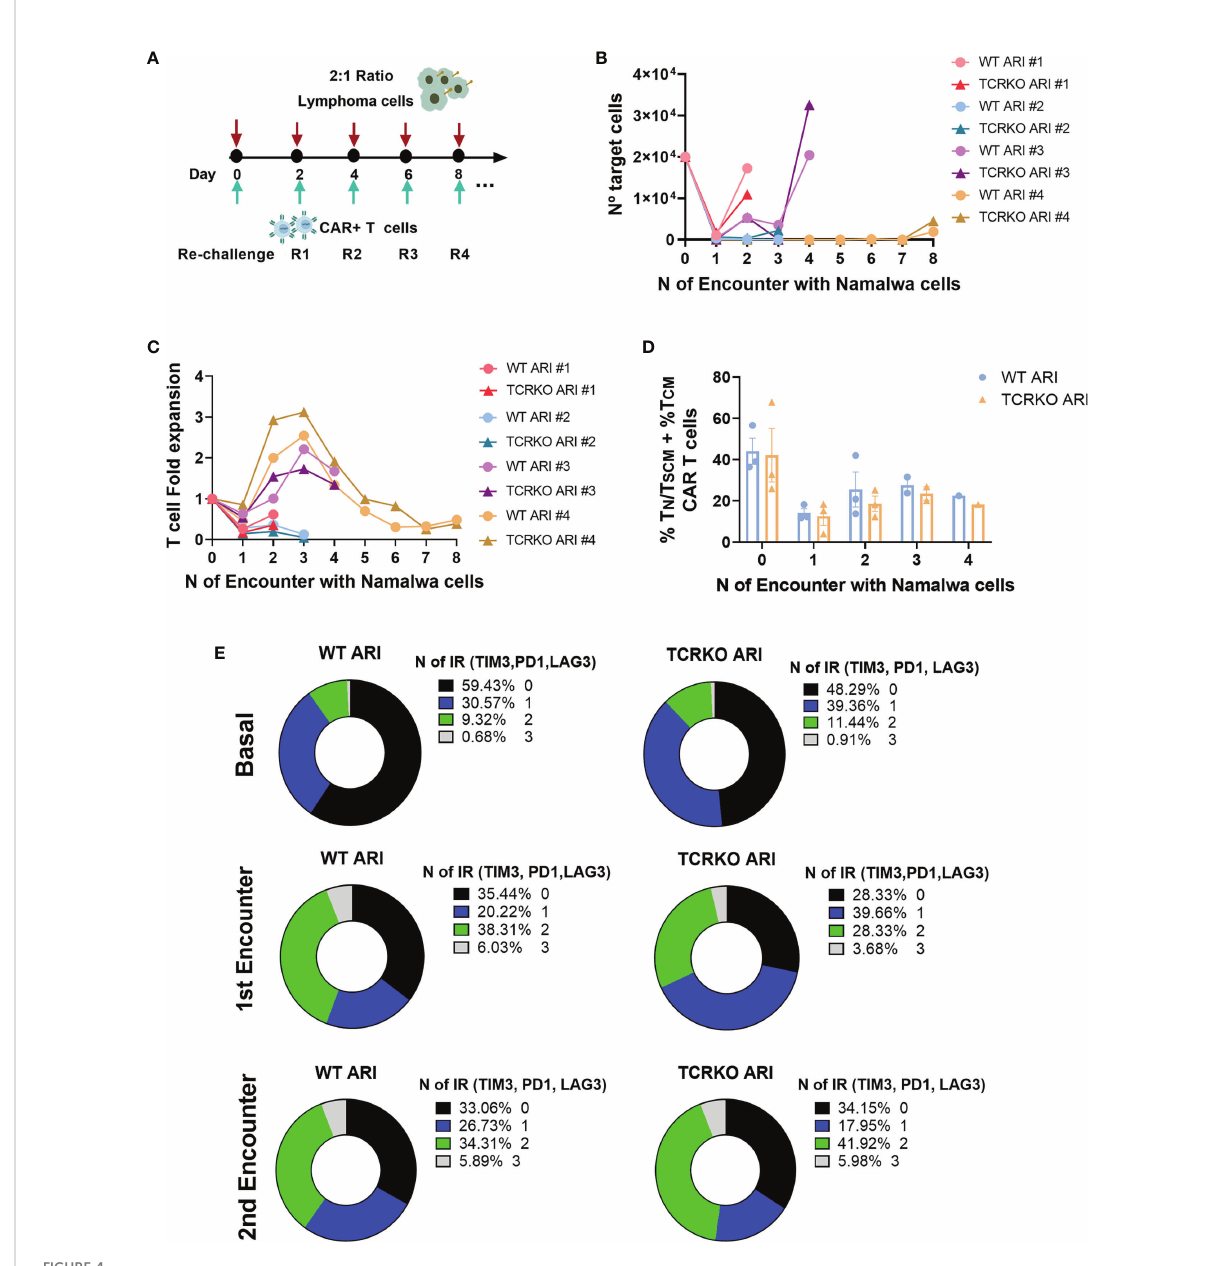
FIGURE 4 TCRKO CAR T cells maintain effector potency after repetitive tumor re-challenge. (A) Scheme of tumor re-challenge assay. CAR T cells were cocultured with Namalwa cells (E:T = 1:2) and rechallenged every two days. (B) Graph showing number of remaining tumor cells quanti fi ed every 48h. (C) T cell fold expansion after every encounter related to the initial numbers of T cells seeded. (D) Percentage of T N /T SCM +T CM of WT ARI-0001 and TCRKO ARI-0001 after the different challenges with Namalwa cells (4 independent donors, n=4). (E) Graphs showing the percentage of expression of 0(black), 1(blue), 2(green) and 3(gray) exhaustion markers/inhibitory receptors (IR) (TIM3, PD1 and LAG3) in WT (left) and TCRKO (right) ARI-0001 CAR-T cells before encounter (basal-top) and after one (1 st encounter-middle) and two encounters (2 nd encounter-bottom) with Namalwa cells (3 independent donors, n=3). Graphs show mean ±